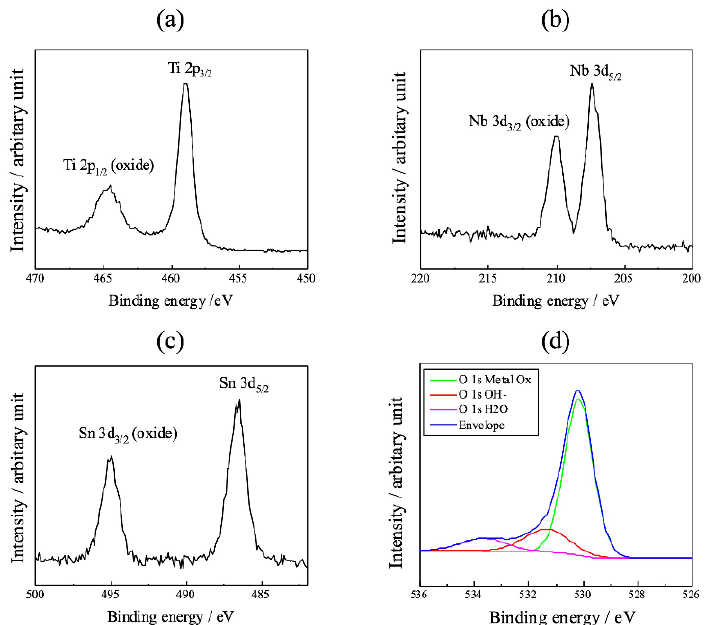
Figure 6. XPS analysis of anodized TiNbSn alloy with hot water treatment . ( a ) Ti 2p; ( b ) Nb 3d; ( c ) Sn 3d; ( d ) O 1s XPS of hot water treated anodic oxide on TiNbSn prepared in the electrolyte with 1 M acetic acid. XPS: X-ray photoelectron spectroscopy.